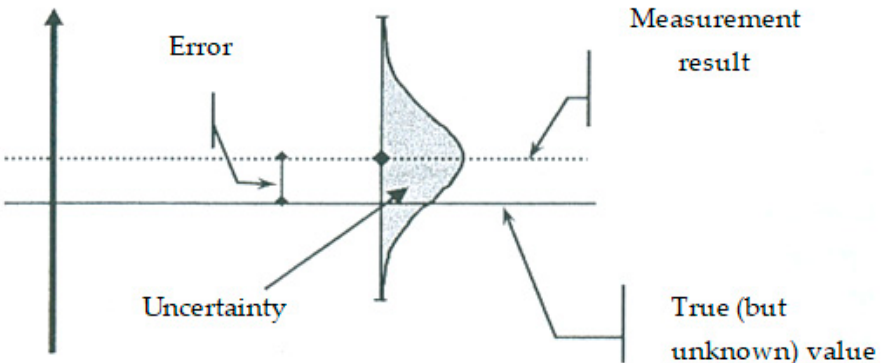
Figure 3. Difference between uncertainty and error.